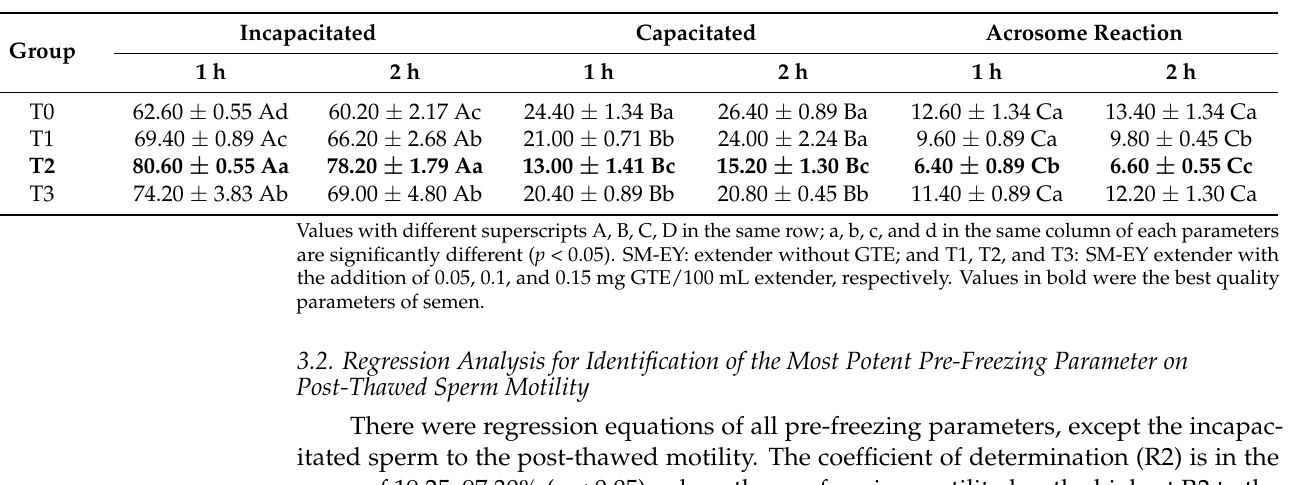
Table 3. Effect of green tea extract (GTE) in skim milk–egg yolk (SM-EY) extender on the capacitation status and acrosome reaction of sperm of post-thawed Kacang buck equilibrated for 1 or 2 h.